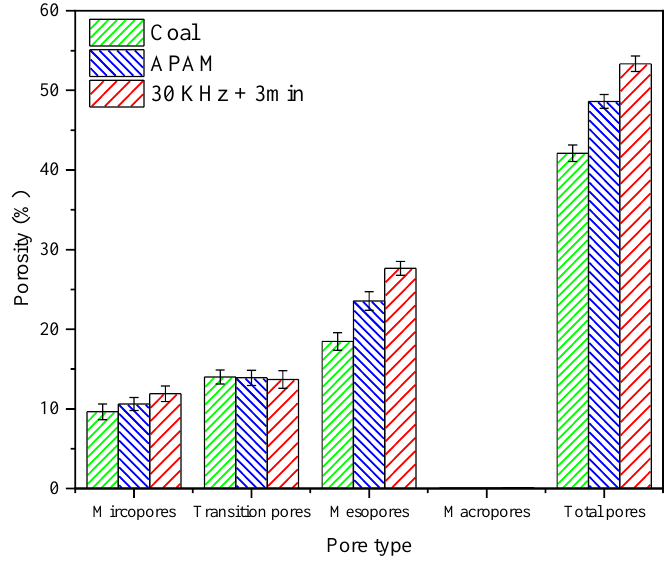
Figure 16. Content of porosity of different types of pores in slurry.